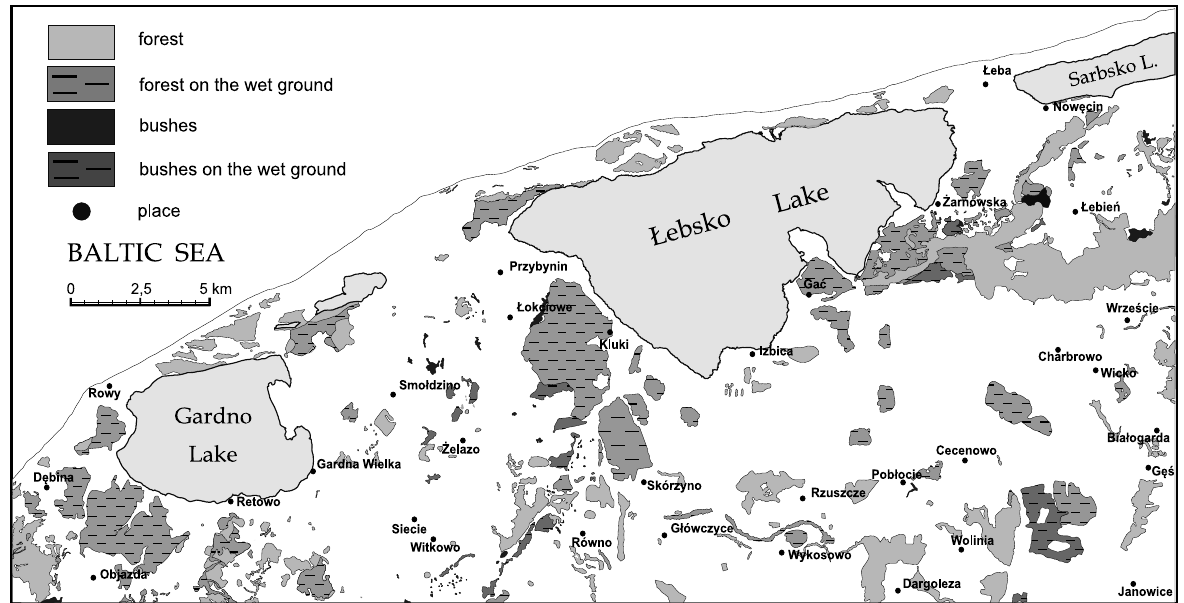
Fig. 8. Extent of forests in Gardno-Łeba Lowland in the early 19th